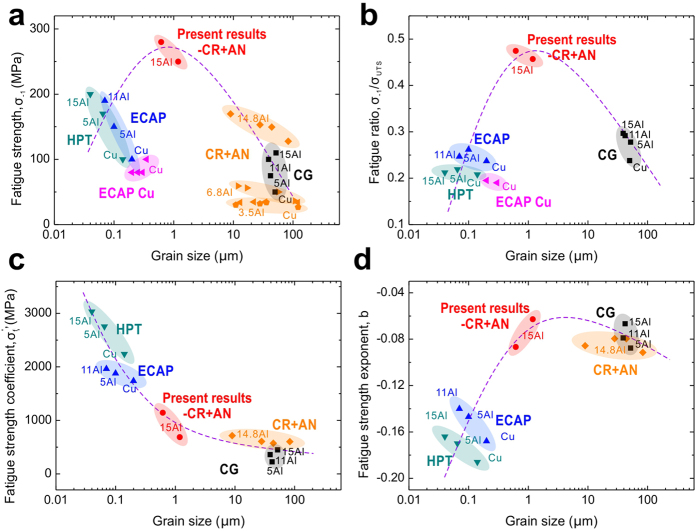
Relationships between fatigue properties and grain size.(a) Fatigue strength and grain size. (b) Fatigue ratio and grain size. (c) Fatigue strength coefficient σf′ and grain size. (d) Fatigue strength exponent b and grain size. σf′ and b are parameters in the Basquin equation. CG/ECAP/HPT: data from the work of An et al.18, the coarse grain/ECAP/HPT structures; ECAP Cu: data from the work of Agnew30, Vinogradov31, Hoppel32 and Han33, the UFG copper produced by ECAP; CR + AN: data from the work of Nishimura et al.34, materials fabricated by cold rolling and annealing. Present results-CR+AN: data in this study, specimens fabricated by cold rolling and annealing.